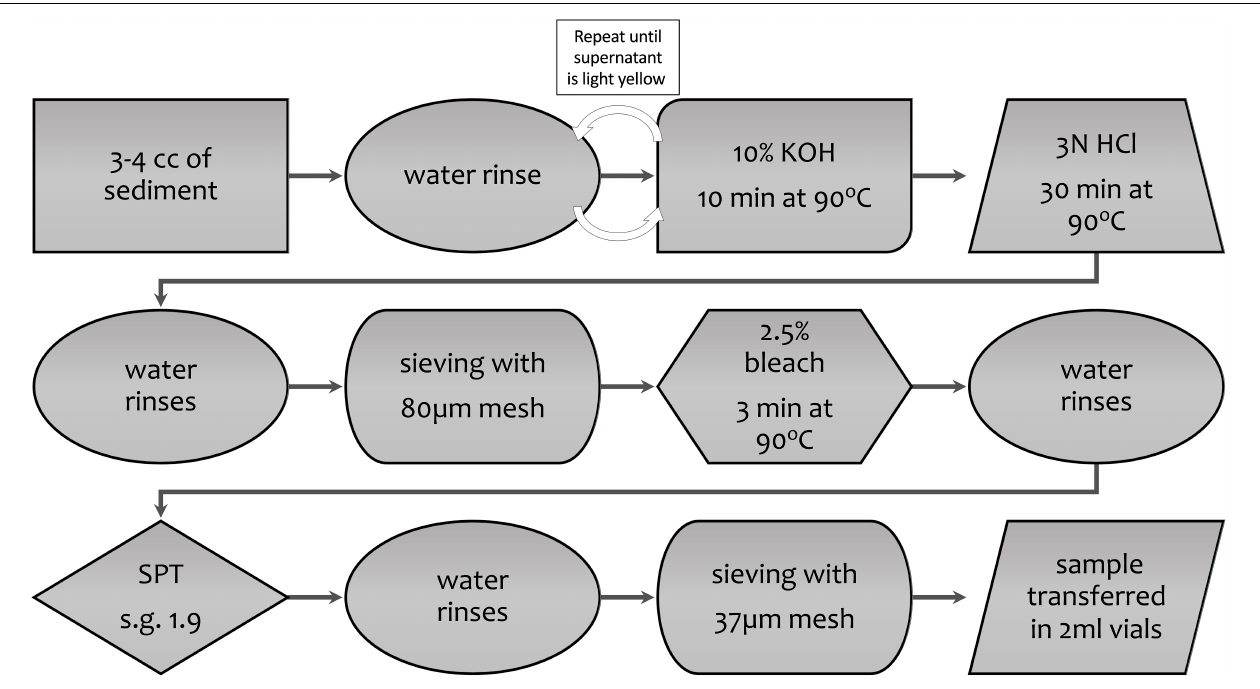
FIGURE 2 | Main steps of the pollen extraction protocol before flow cytometry, including base, acid, bleach, and heavy-liquid steps. Water rinses are indicated by ovals; note that there is no water rinse between the base and acid steps. Size of meshes used for the various steps must be tested and modified depending on the sample and pollen types and other material included in the samples; in every case, the size fractions should be examined to determine into what fraction the pollen